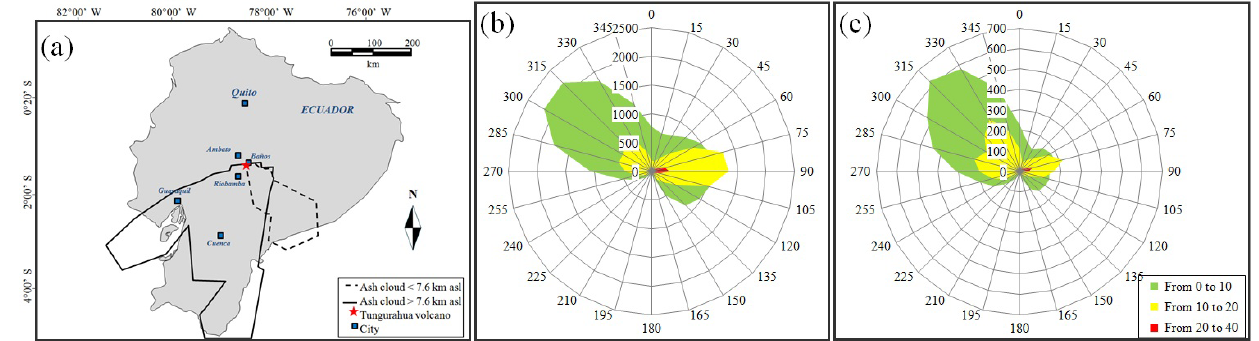
Figure 2. Plume dispersion and wind patterns. (a) Ash cloud dispersion during the 1 February 2015 eruption at different fly levels ( < 7.6 and > 7.6kma.s.l.), as obtained from VAAC. (b, c) Rose diagrams showing the frequency of the wind direction at an altitude of 15kma.s.l. during the whole year and from January to March (data acquired from 1999 to 2011). The colour of the series represents the wind speed measured in metres per